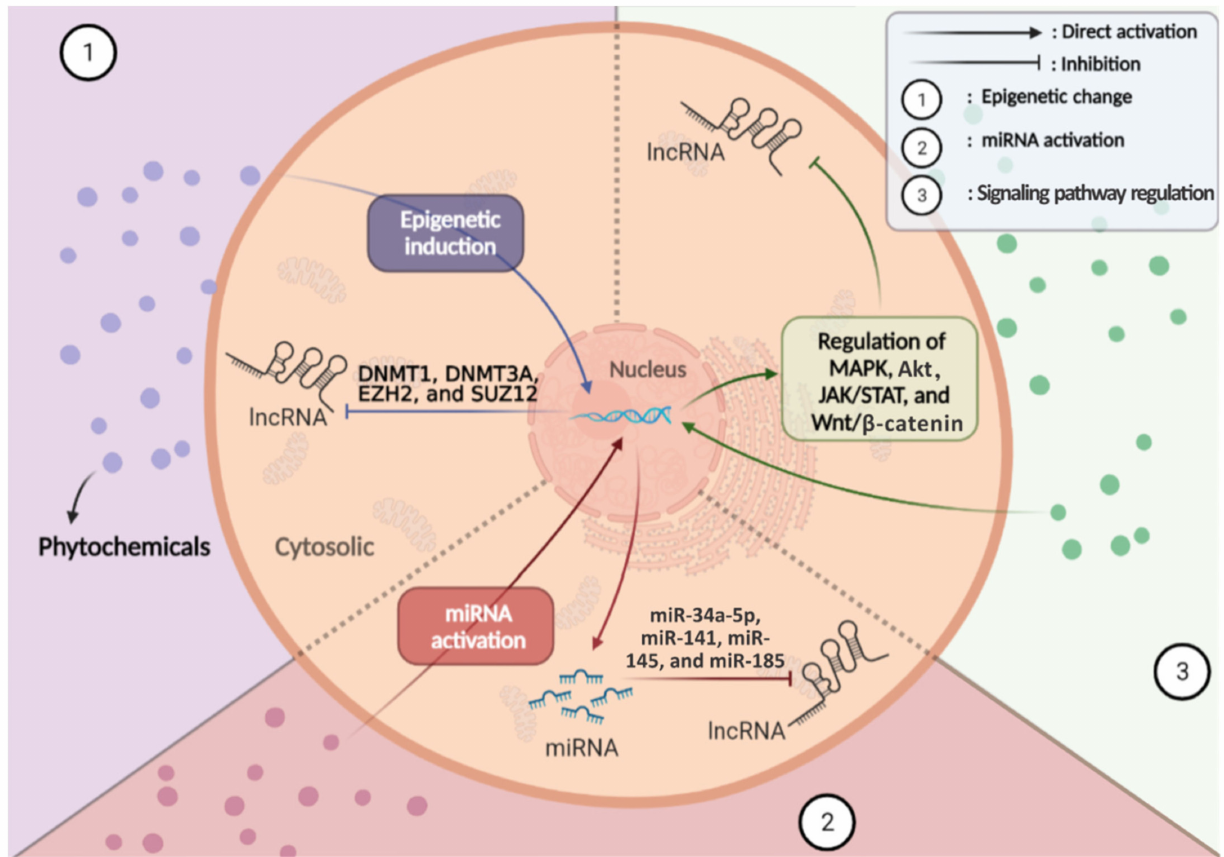
Figure 3. Molecular mechanisms action of phytochemicals for regulation of lncRNAs in cancer (Created using resources at